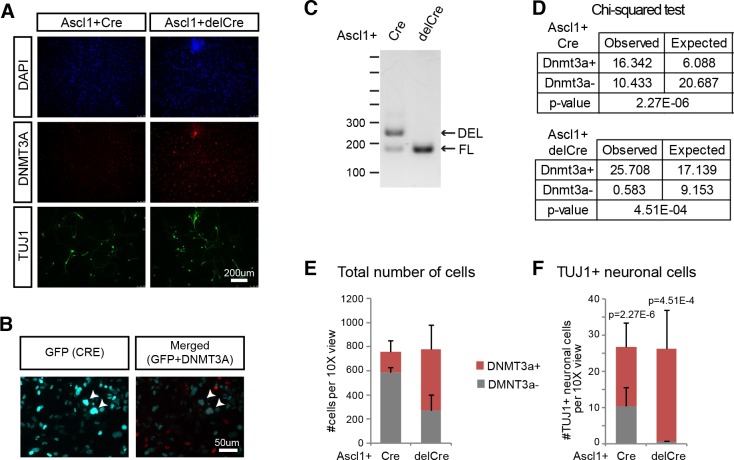
Deletion of Dnmt3a/3b in fibroblasts leads to reduced reprogramming efficiency. (A) 10X view of immunostaining in Ascl1 +CreGfp/delCreGfp samples. (B) Corresponding GFP staining (for CREGFP fusion protein) for Figure 5C. Even though iN cells are expressing high levels of CRE, which should loop out the Dnmt3a locus, cells are still expressing DNMT3A protein. (C) Genotyping of Dnmt3a/b fl/fl cells. Floxed mutant bands (FL) appear at ~200 bp while deleted bands (DEL) appear at ~250 bp. (D) Chi-squared test for significance for Figure 5—figure supplement 1E–F. The null hypothesis is that if Dnmt3a- cells reprogram as well as the Dnmt3a + cells, there should be no significant difference in the frequency of Dnmt3a- cells and the frequency of cells that actually reprogram into neurons. There is a significant difference for both Cre (p=2.27E-6) and delCre (p=4.51E-4) conditions, indicating that Dnmt3a- cells are less efficient in reprogramming into iN cells. (E and F) Average counts of DAPI +cells (E) or TUJ1 +iN cells (F) 14d post-Ascl1 induction that are either DNMT3A positive (red) or negative (gray) per 10X field of view. Using a Chi-squared test (Figure 5D; Figure 5—figure supplement 1D), there is a significant difference between the frequencies of total number DNMT3A- cells compared to the number of DNMT3A- iN cells in both Cre and delCre conditions.